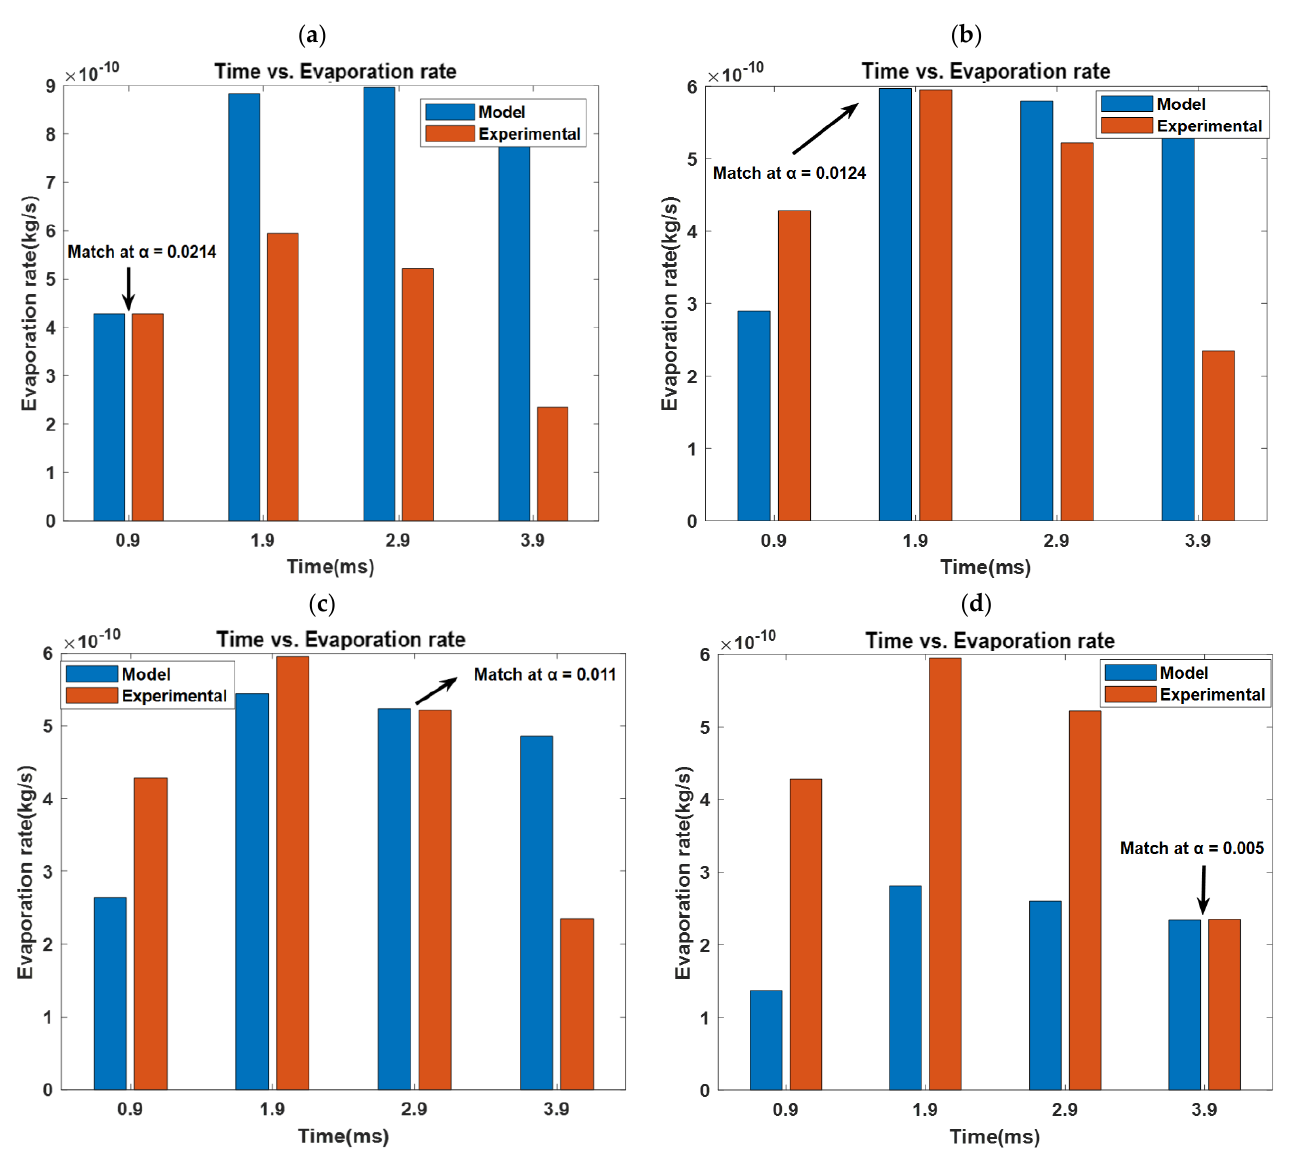
Figure 13. A comparison between the evaporation rates of the model and experimentally derived wall heat flux at various times of 0.9 ms ( a ), 1.9 ms ( b ), 2.9 ms ( c ), and 3.9 ms ( d ). The accommodation coefficient could be estimated through iterative matching. The results suggest that the matched co- efficient reduces with time.